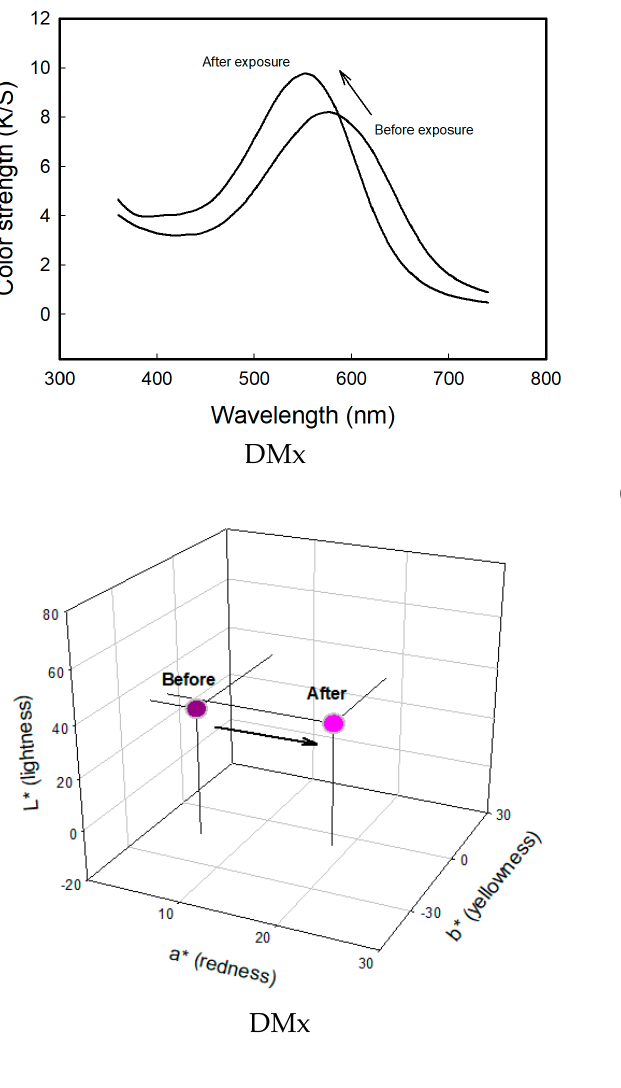
Figure 5. ( a ) Rate of color change in cellulosic fabrics dyed with DMx and DM upon exposure to DMAc, MeOH, and acetone. ( b ) Change in color spectra of dyed samples exposed to 300 ppm DMAc for 24 h. ( c ) Color coordination before and after exposure to 300 ppm DMAc.